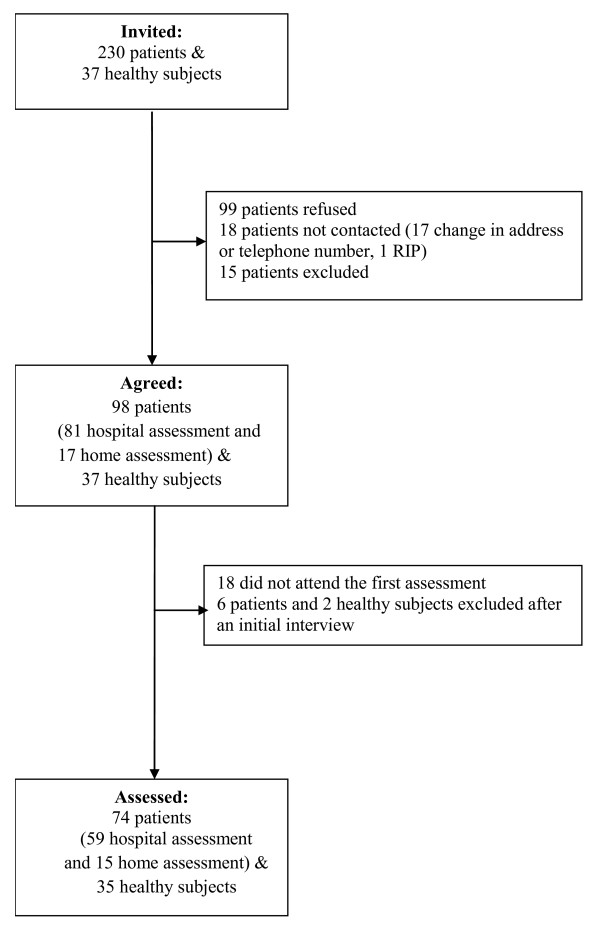
Flow chart of recruitment and assessment.